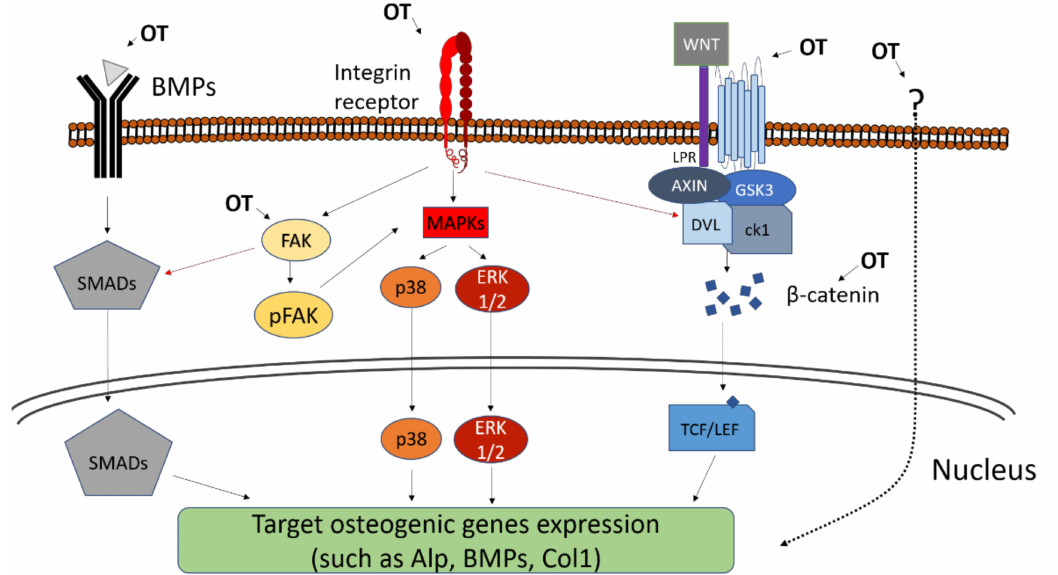
Figure 1. Schematic figure of the topography-induced osteogenesis. Some pathways and proteins are shown to be related to this activation, including MAPK pathway, Focal Adhesion Kinase (FAK) activation, BMPs and the Wnt/b-catenin pathway. An osteogenic topography (OT) can activate these pathways in several ways, such as: (1) in the MAPK pathway, activation occurs from the connection to integrins, leading to activation and translocation to the nucleus of p38 and ERK 1 / 2 ; (2) BMPs, when connecting to a BMP receptor, trigger the activation and translocation of SMADs; (3) and the Wnt protein complex coupled to its specific receptor trigger the accumulation of beta-catenin and its translocation to the nucleus. Other forms of topography-induced osteogenic phenotype are not yet fully elucidated (dotted arrow), but it is known that the activation of the FAK and beta-catenin pathways may be involved and be activated through other pathways not yet